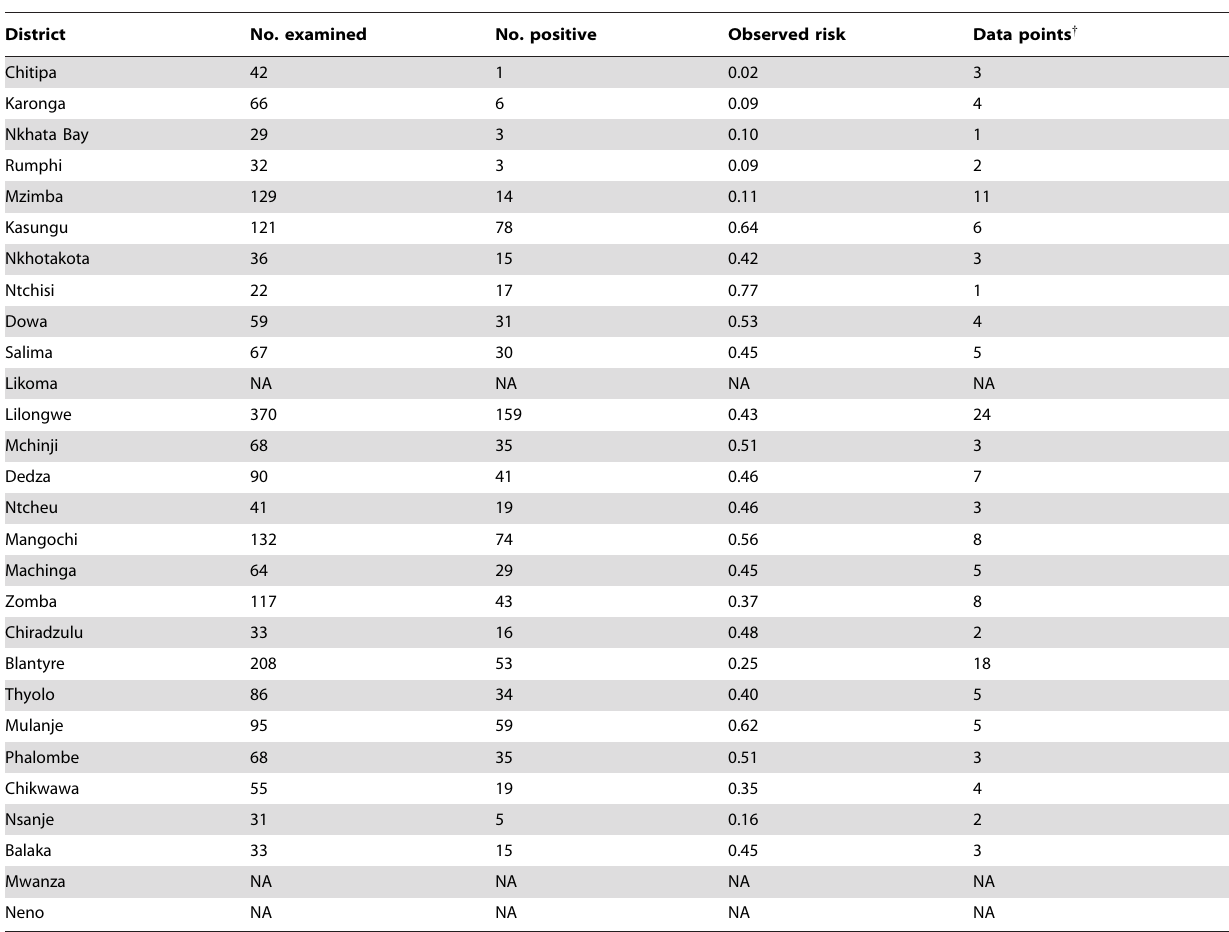
Table 1. Under five malaria prevalence by district.